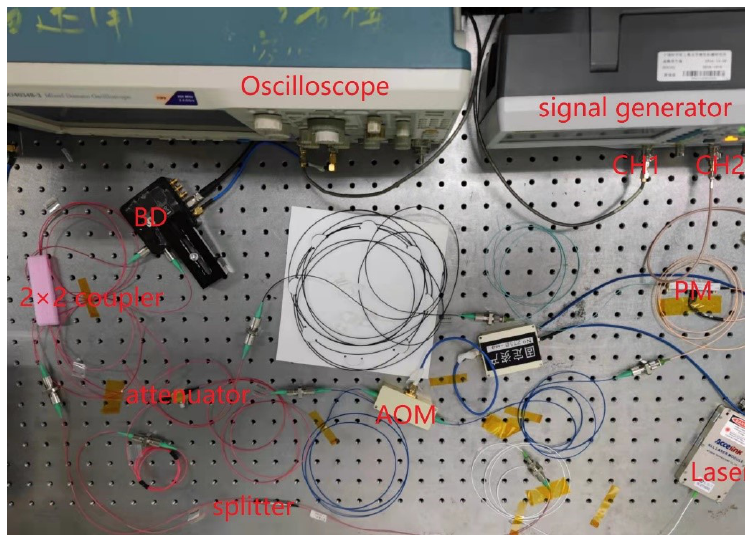
Figure 5. Photo of the experimental devices.